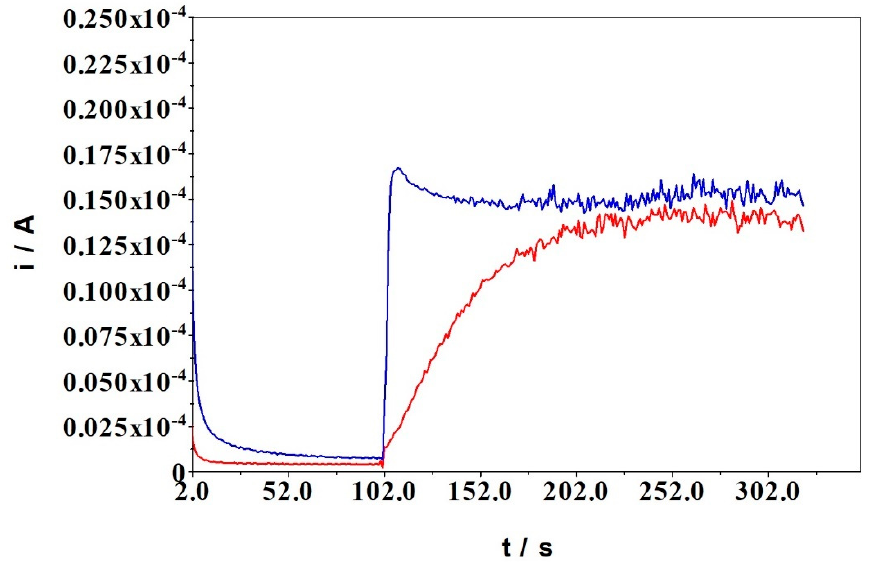
Figure 2. Amperometric response for: (blue line) 0.64 mM cholesterol added in the mixture (2 mL chloroform-TBAP + 1 mL acetic anhydride + 40 µ L H 2 SO 4 ) and (red line) 40 µ L H 2 SO 4 added in the mixture (2 mL chloroform-TBAP + 1 mL acetic anhydride + 0.64 mM cholesterol). Applied potential 1.5 V.